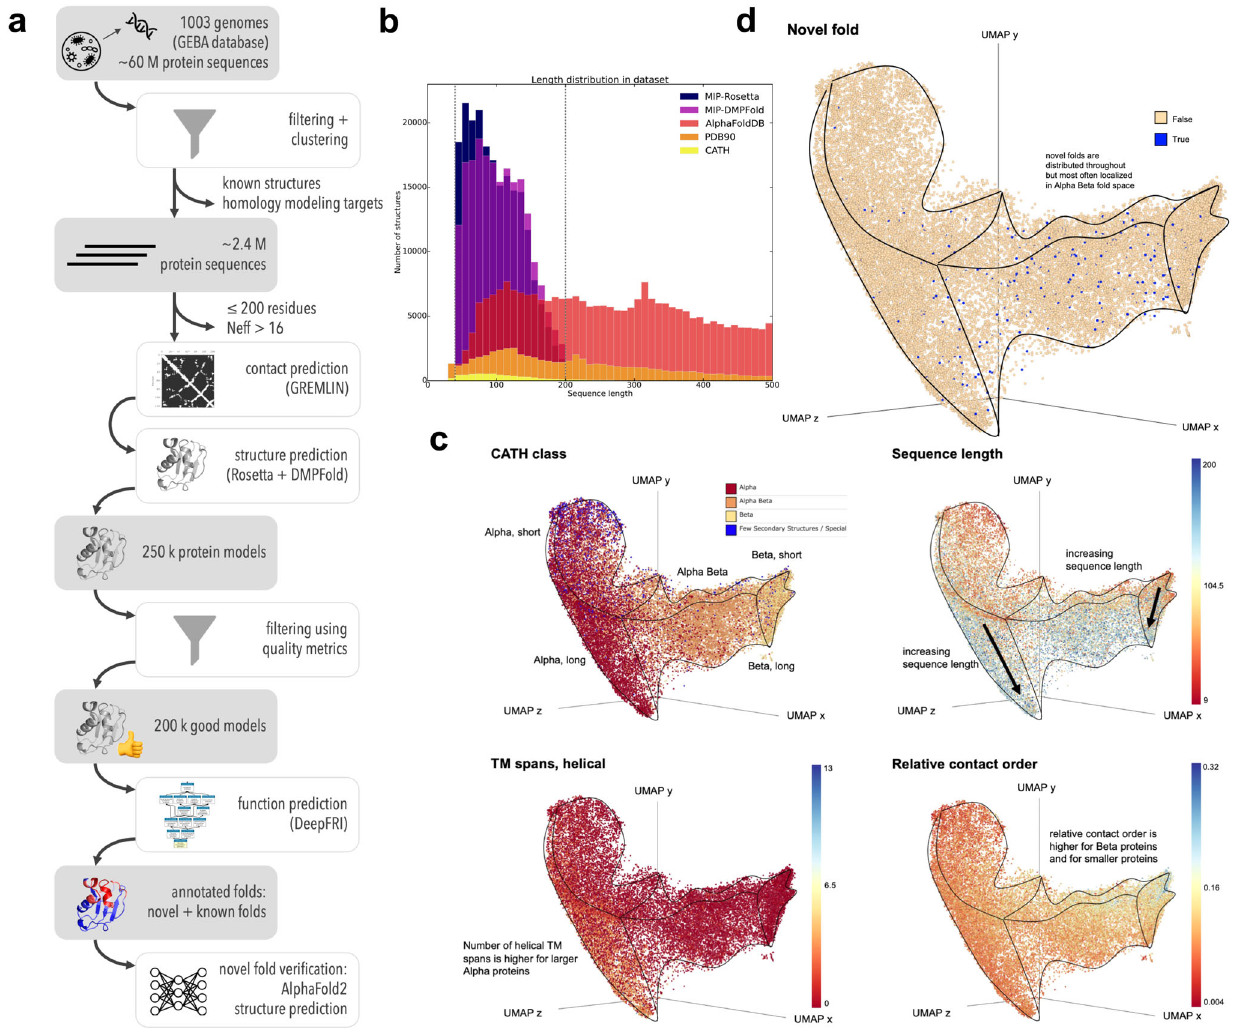
Fig. 1 | The fold space covered by the microbial protein structure universe is continuous. a Flowchart of our process to arrive at ~200,000 de novo protein models covering a diverse sequence space. b The sequence length distribution shows that our sequences are shorter than many of the proteins in the PDB, CATH orAlphaFolddatabases,asexpected.Wepredictedstructuresbetween40and200 residues long, which covers the majority of length distributions in microbial pro- teins, which are often shorter than eukaryotic sequences. c The protein structure